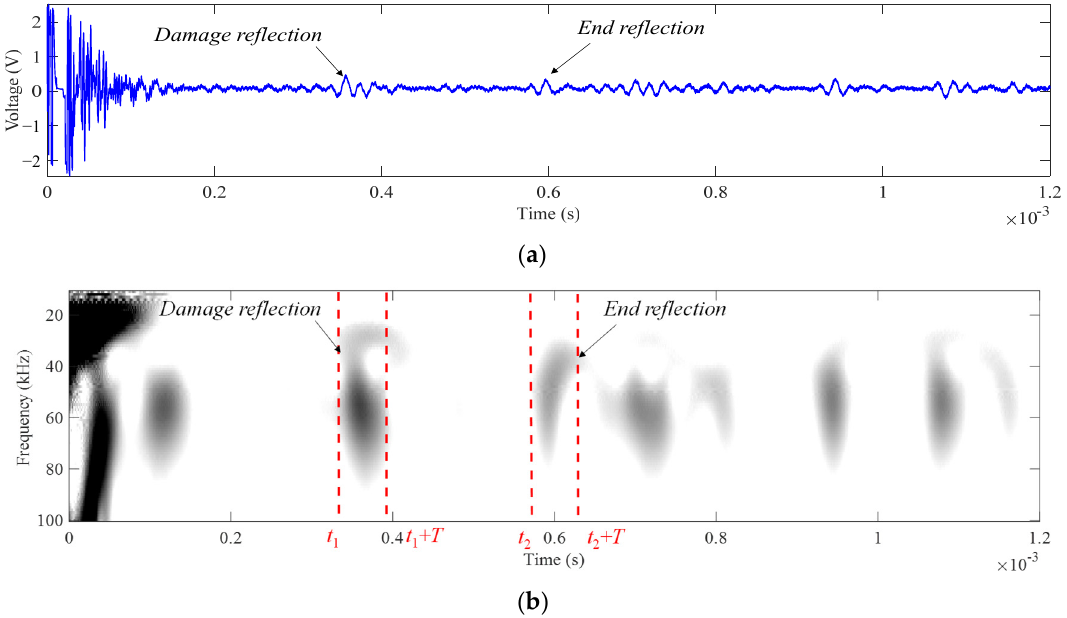
Figure 13. ( a ) The received signal and ( b ) its complex Morlet wavelet transform result for the second damage case.